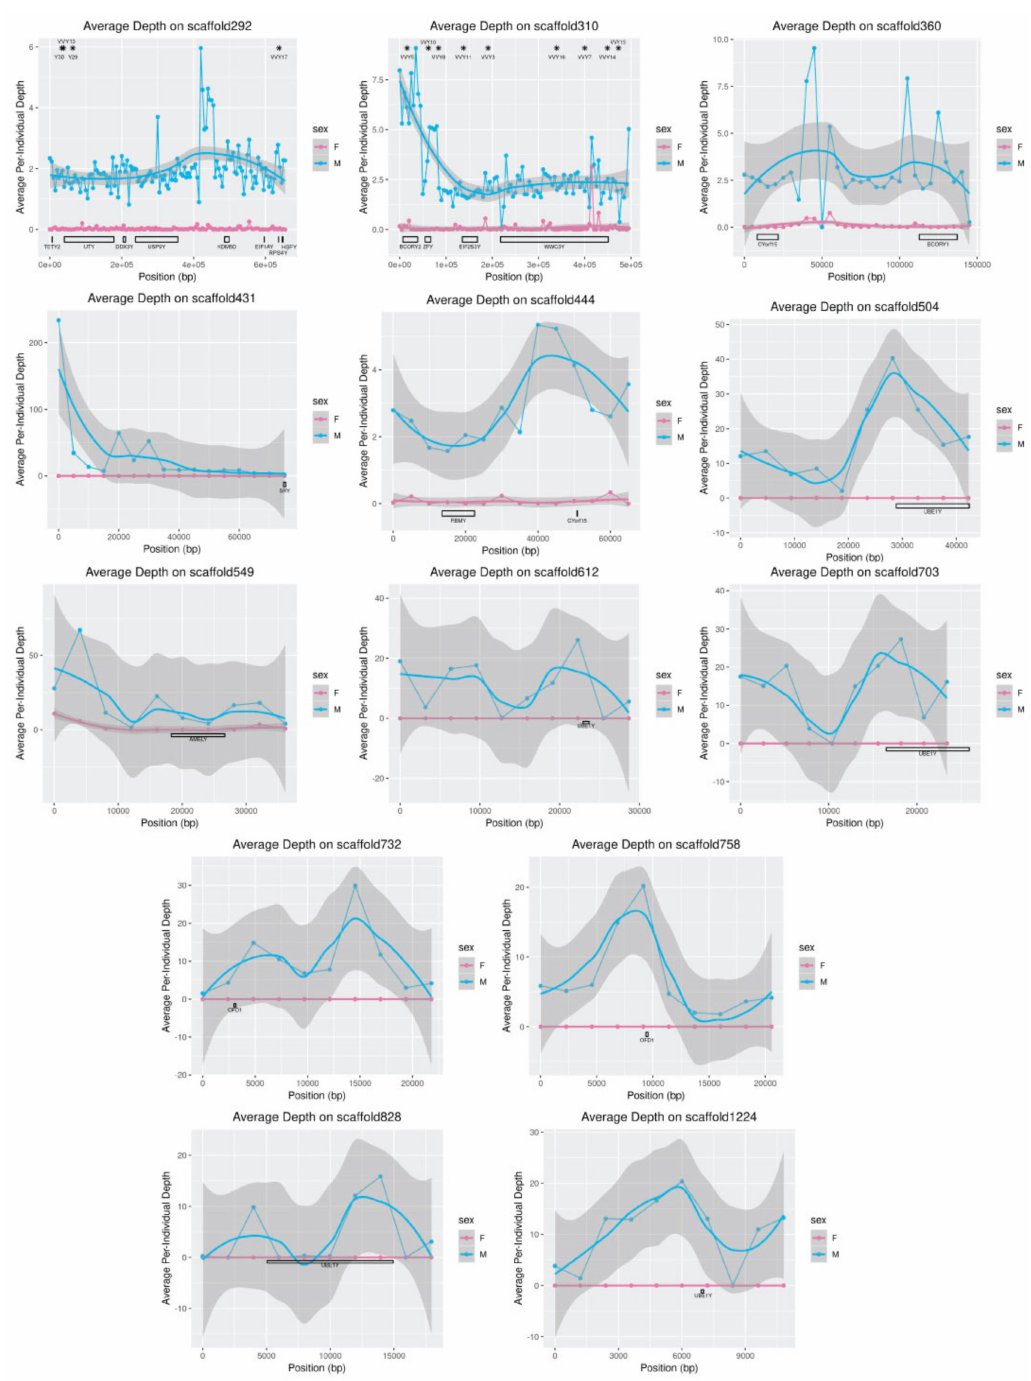
Figure 5. Depth of coverage of Y-sca ff olds by male and female resequencing reads. Depth was averaged in males and females over 5000-bp windows for sca ff olds longer than 50 Kbp, or for windows 10% of the sca ff old length for shorter sca ff olds. Microsatellite marker positions [28] are indicated along the top with stars; gene positions as identified in Table 3 are indicated along the bottom. Only sca ff olds containing genes are shown. Axes vary depending on the observed depth ( y ) and the length of the sca ff old ( x